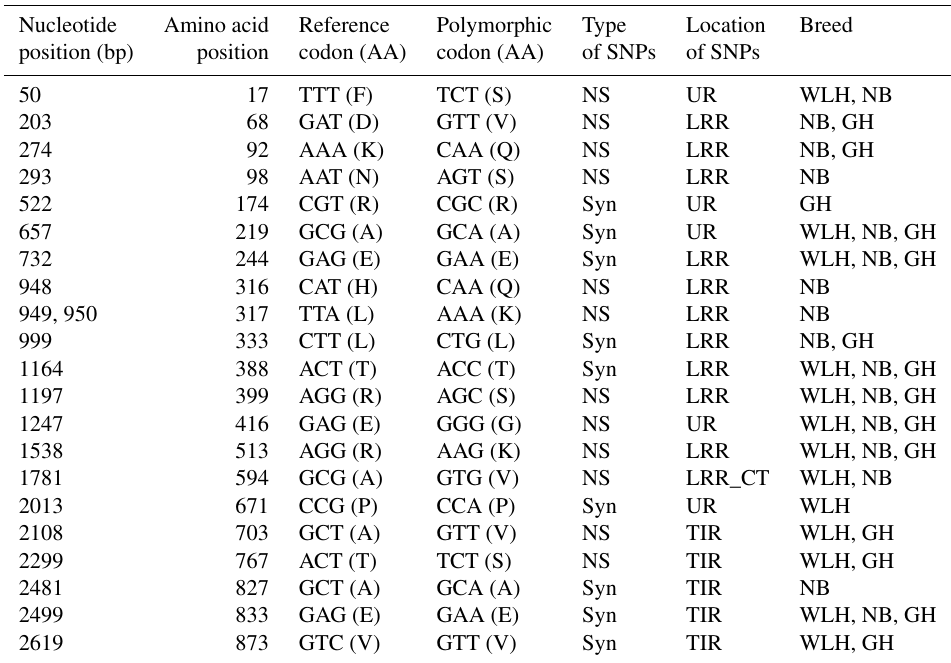
Table 2. Polymorphisms in the TLR3 gene of different chicken breeds. Nucleotide Amino acid Reference